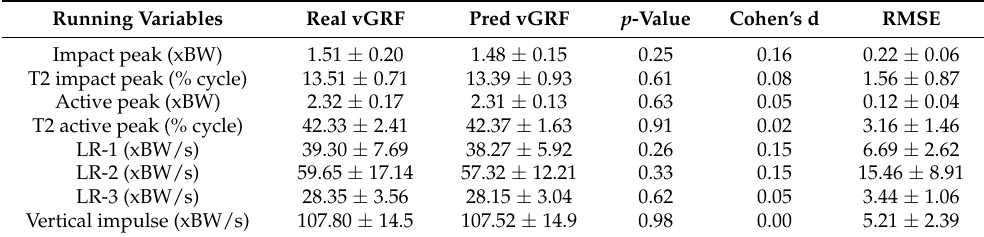
Table 2. Comparison between running biomechanical variables extracted from the real vertical ground reaction forces (vGRF) and the predicted GRF. T2 = time to; LR = loading rate; BW = body weight; rRMSE = relative root-mean-square error.